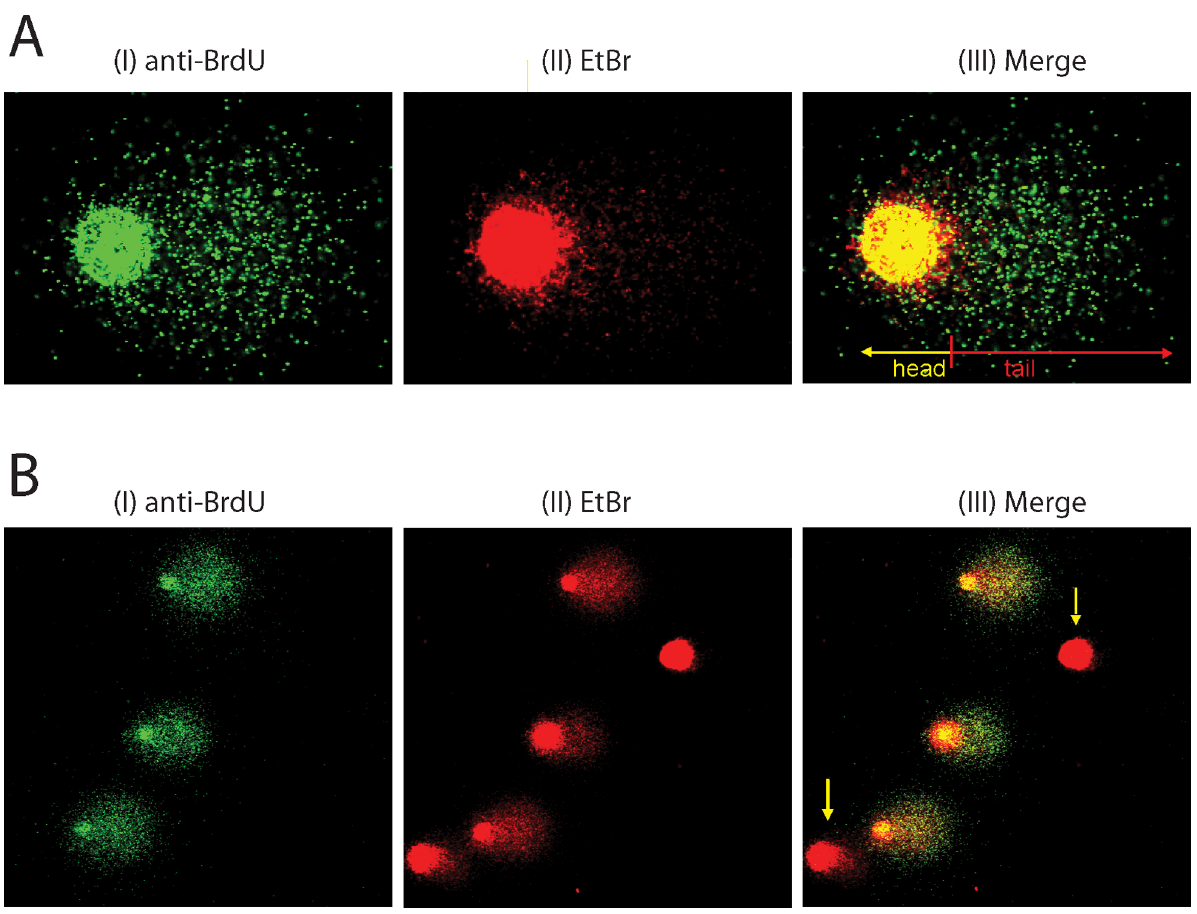
Figure 3. Alkaline BrdU comet PRR images of HCT116(RAD18 2 / 2 ) cells after UV irradiation. ( A ) UV irradiated (20 J/m 2 ) cells were allowed to recover for 6 hour. Representative images of UV treated cells display highly discontinuous, fragmented tails. The modified BrdU comet assay allowed proper differentiation between comet head and tail, which is essential for precise quantitation. Following the BrdU comet assay, the incorporated BrdU was identified by anti-BrdU primary antibody and cells were detected using Alexa Fluor 488 conjugated secondary antibody (green, panel I). Ethidium bromide counterstaining of the same cells (red, panel II) and merged images (yellow, panel III) are shown. ( B ) BrdU immunostaining detects S-phase cells without synchronisation. HCT116(RAD18 2 / 2 ) cell were UV irradiated (40 J/m 2 ) and allowed to recover for 6 hour. Staining was carried out as described in (A). Arrows indicate the non-S-phase cells which has not been stained with anti-BrdU antibody but only with ethidium